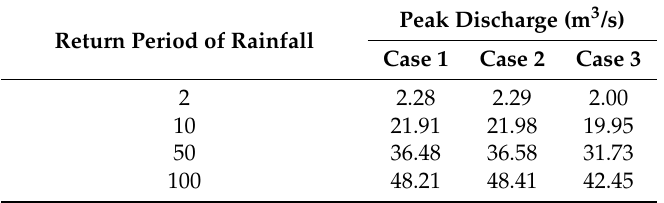
Table 5. Comparison water level peak values for different land use scenarios.